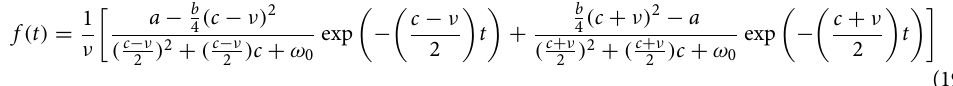
Figure 1. MAP estimations of the parameters using the Bayesian inference from simulated time series of various sampling time ( T s ) and sampling time step ( (cid:31) t ) normalized by the longest ( τ 1 ) and the shortest ( τ S ) time scales of the process. ( a ) Estimated trap stiffness normalized by the input in the simulation ( k using Bayesian I. The inferences of ( b ) the time constants normalized by the input τ viscosity divided by the corresponding input η Pa s, using Bayesan II and the values of the trap stiffness calculated from Bayesian I. The shaded regions correspond to one standard deviations of the estimations. Clearly, when the (cid:31) t is greater than τ S , the standard errors of estimations decrease with the increase of T s . Blue triangles are the calculated parameters from the best fit of the